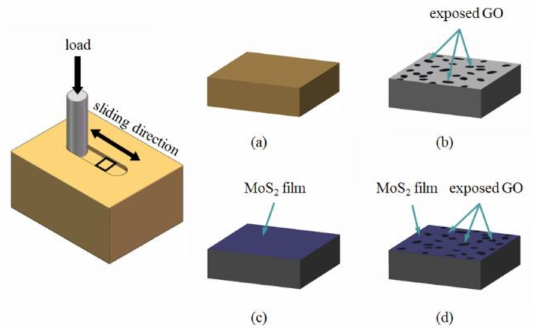
Figure 4. Schematic illustration of friction and wear of PEEK ( a ), PEEK / GOs ( b ), PEEK / MoS 2 s ( c ), and PEEK / GO / MoS 2 ( d ).